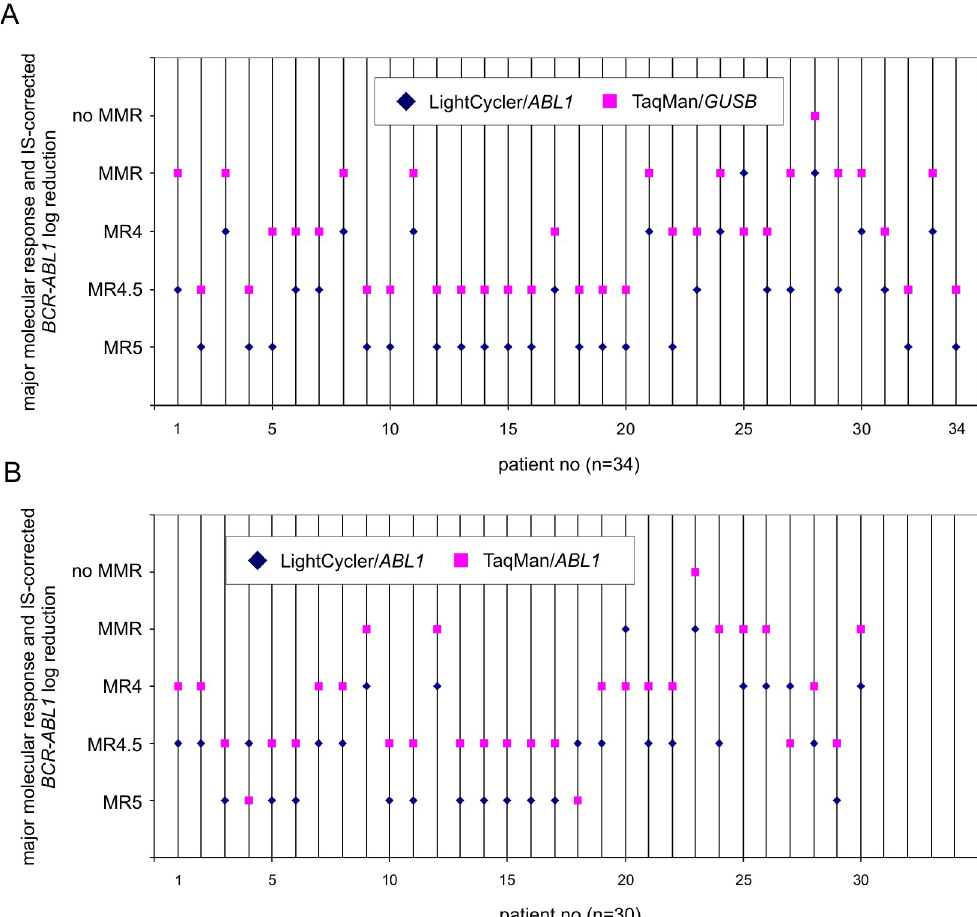
Fig 3. Diagnostic outcome. A. Assay-related shifts (n = 34) in the diagnostic outcome of 92 CML patient samples were analyzed with the TM/ GUSB combination (pink squares) instead of LC/ ABL1 combination (blue diamonds). B. Assay- related shifts (n = 30) in the diagnostic outcome of 92 CML patient samples were analyzed with the TM/ ABL1 combination (pink squares) instead of LC/ ABL1 combination (blue diamonds). Abbreviations: MMR, major molecular response; MR 4 indicates � 4-log reduction (BCR-ABL1 IS � 0.01%), MR 4.5 indicates � 4.5-log reduction (BCR-ABL1 IS � 0.0032%), and MR 5 indicates � 5-log reduction (BCR-ABL1 IS � 0.001%). The prerequisite for valid calculation of major responses (log reduction) is a sufficient RNA quality as given by the absolute copy numbers of housekeeping gene GUSB